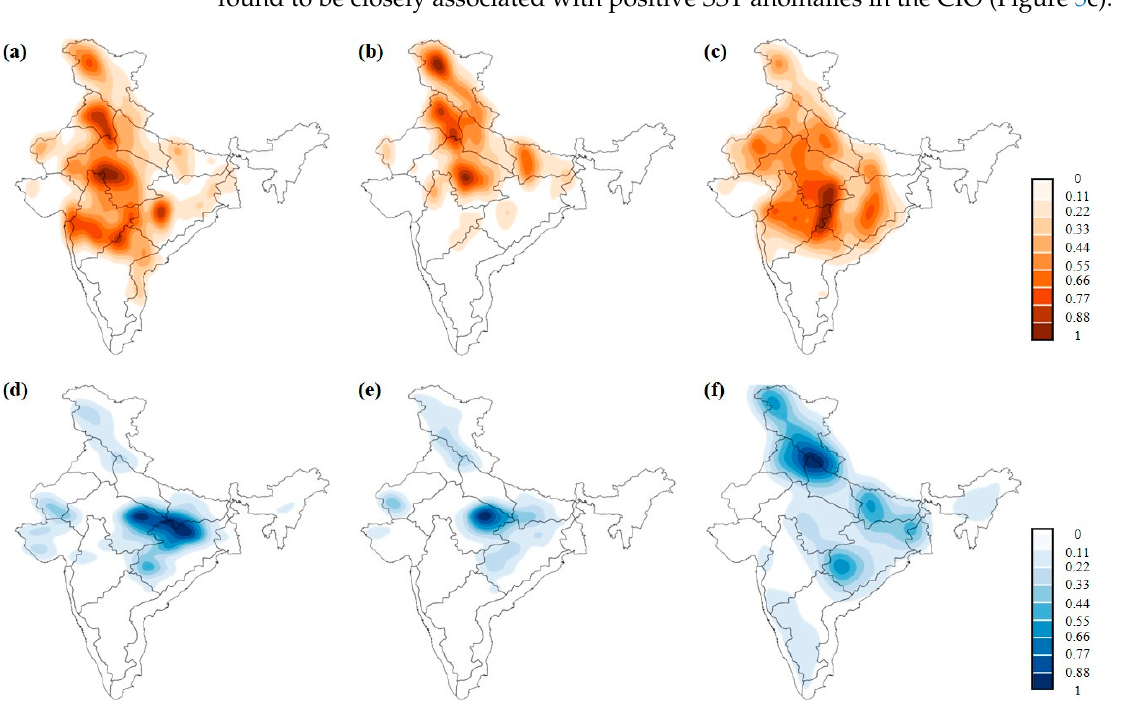
Figure 5. Regions showing statistically significant composite anomalies of SIF (W m − 2 µ m − 1 Sr − 1 ) across India during the month of June when SST anomalies of the Western Indian Ocean ( a , d ), Northern Indian Ocean ( b , e ) and Central Indian Ocean ( c , f ) demonstrated positive (upper) and negative (lower) trends. The colour bar shows the scaled density estimate of negative (orange) and positive (blue) SIF anomalies. The warmer SST in the oceanic regions leads to negative SIF anomalies, while the colder SST leads to positive SIF anomalies.